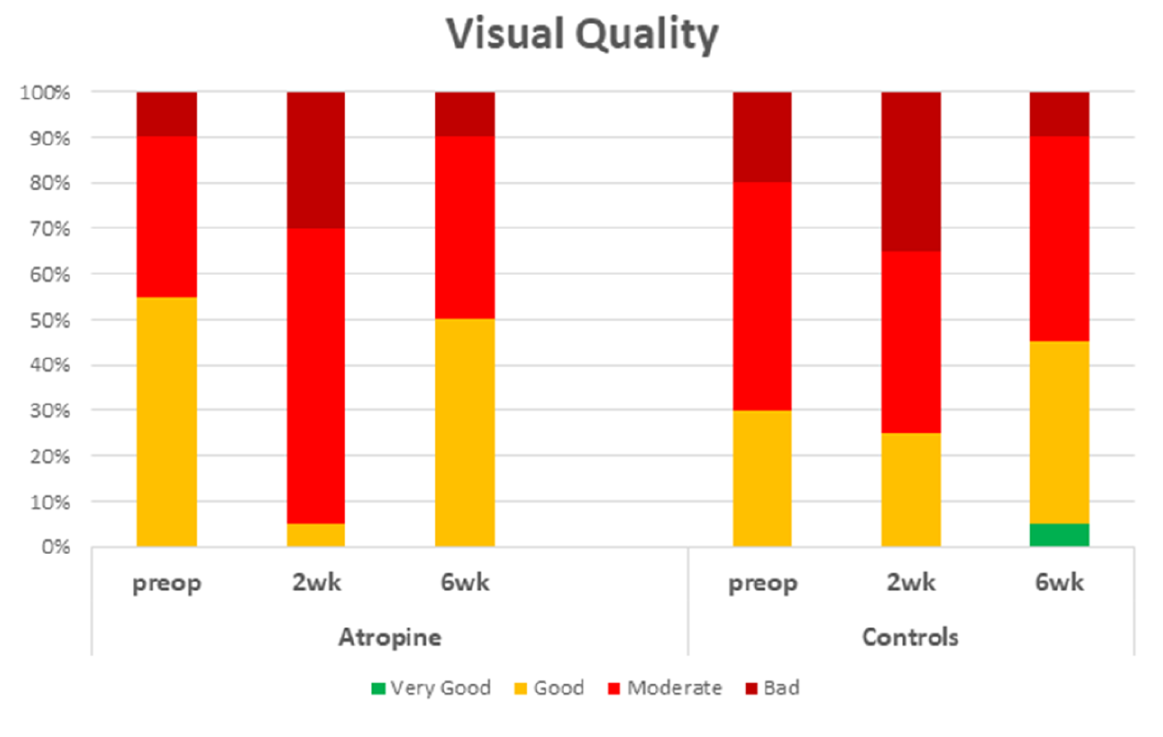
Figure 2. Overall visual quality in both groups. The percentage of patients given each possible value is presented. In the atropine, group there is an obvious reduction in visual quality reported two weeks after surgery compared with the preoperative evaluation. In the control group, there is no significant reduction in the visual quality. Six weeks after surgery, both groups report visual quality comparable to their preoperative status.